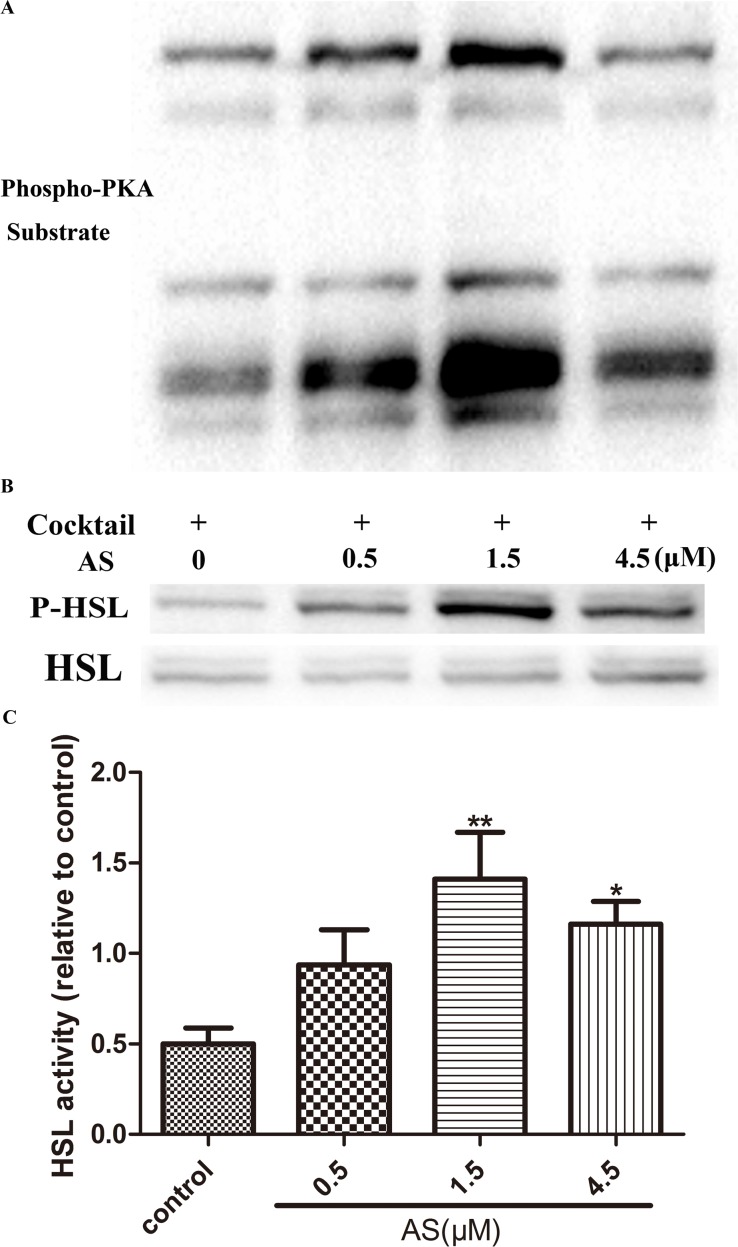
AS induces lipolysis in mature adipocytes by activating the phosphorylation and activity of PKA and HSL.Fully differentiated 3T3-L1 adipocytes were incubated in the absence and presence of various concentrations of AS (0, 0.5, 1.5, and 4.5 μM) for 3 h. Immunoblots are representative of seven independent experiments; β-actin served as a loading control. *P < 0.05, **P < 0.01, ***P < 0.001 vs. untreated adipocytes at the same time point.